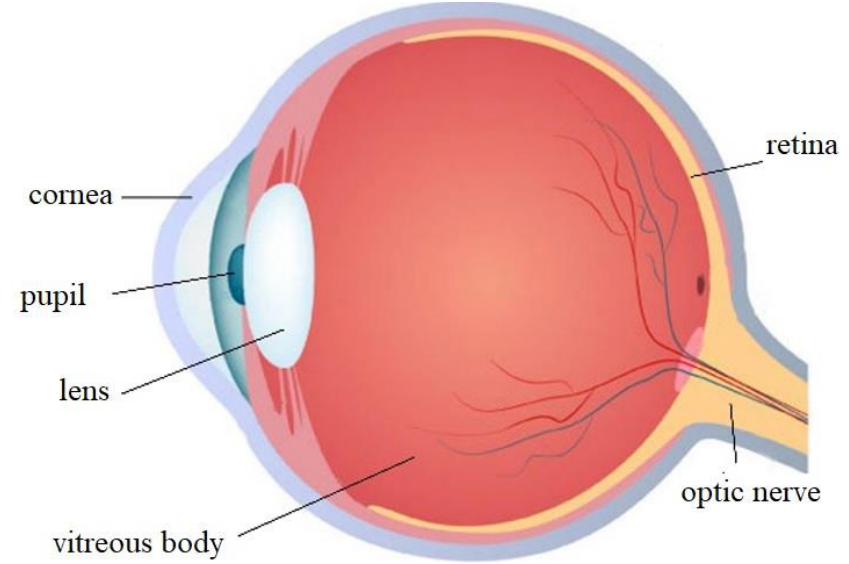
Figure 3. Structure of the eyeball.